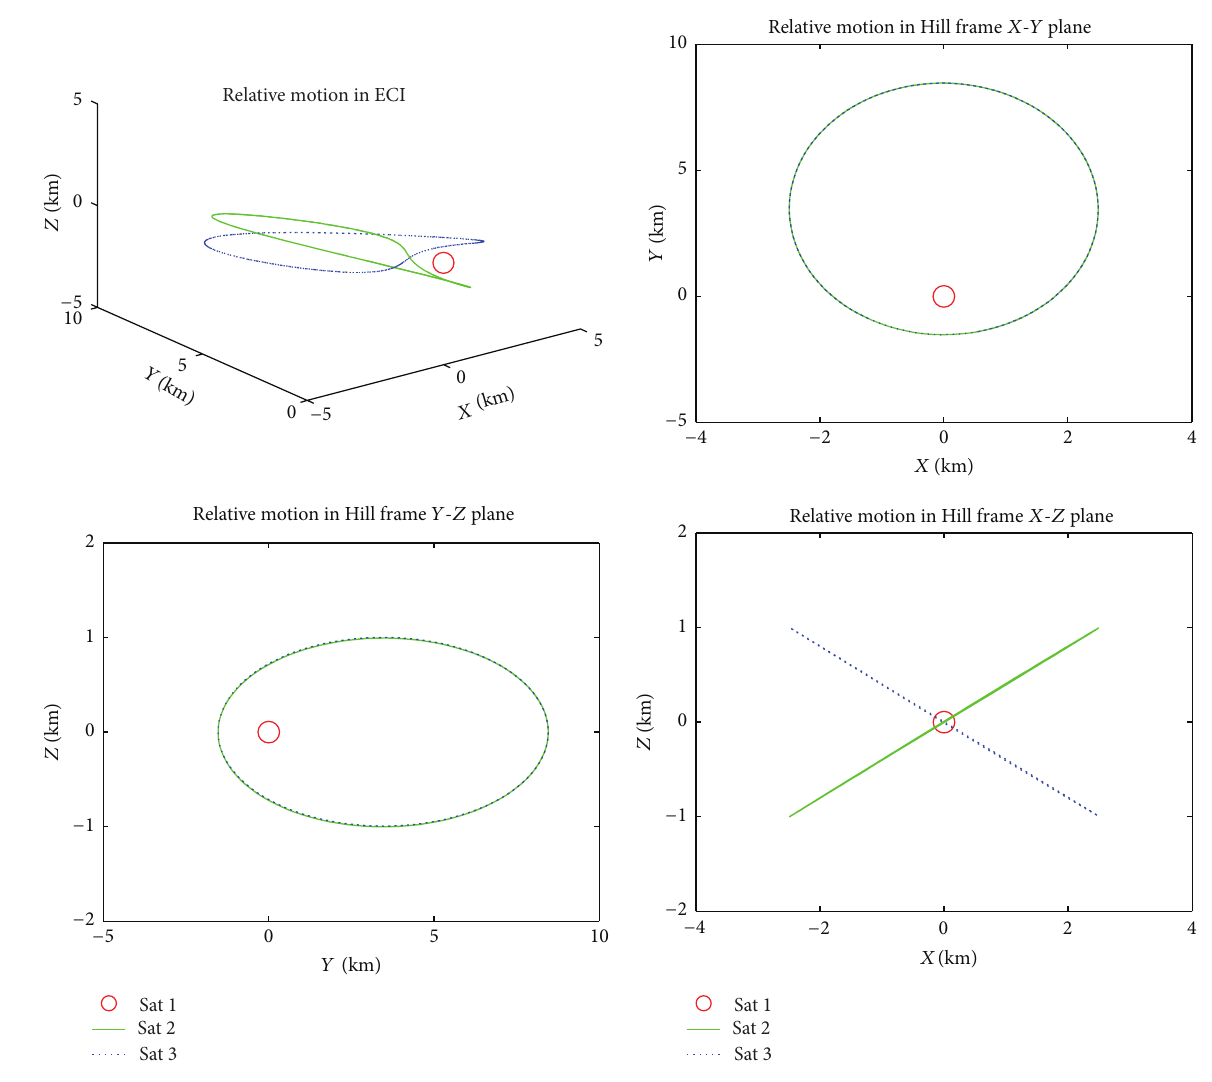
Figure 6: Relative motion between satellites.